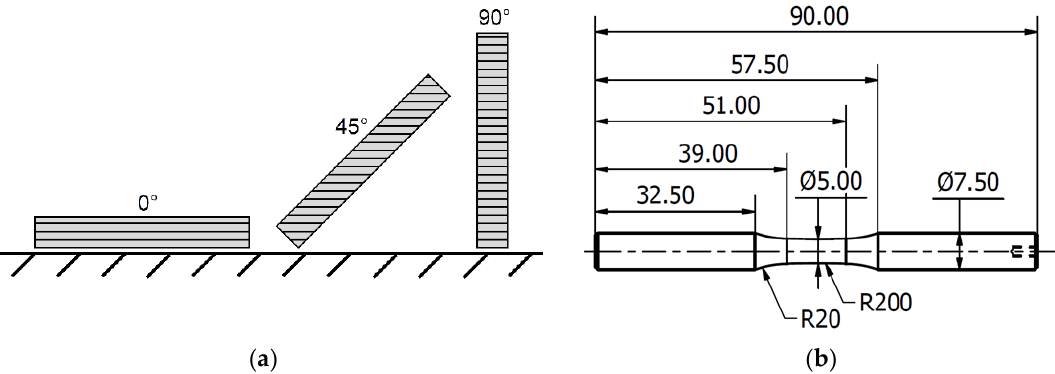
Figure 1. ( a ) Building orientations for SLM AlSi10Mg samples; and ( b ) specimen geometry for tensile and fatigue tests (dimensions in